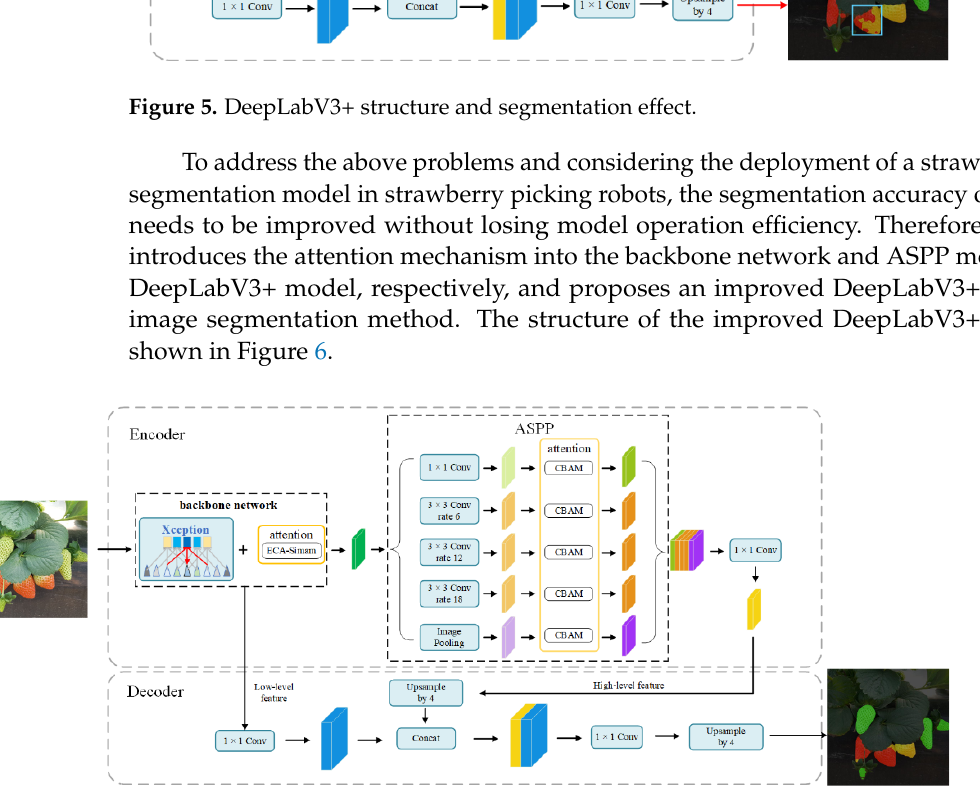
Figure 6. Improved DeepLabV3+ network structure diagram.